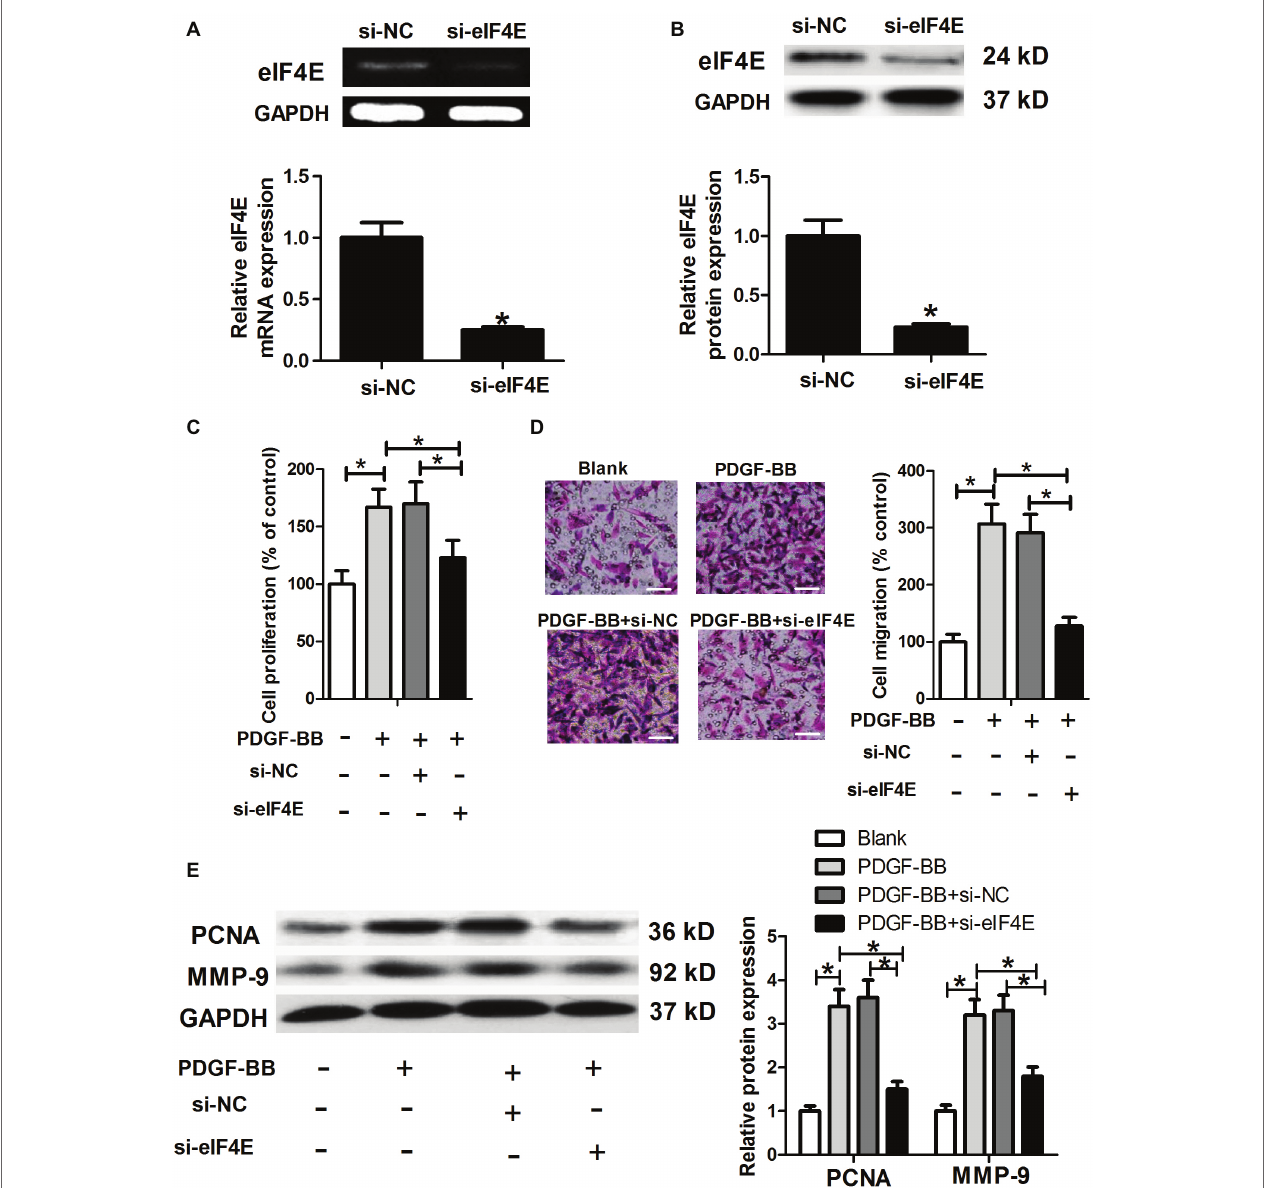
FIGURE 5 | eIF4E knockdown inhibits PDGF-BB-induced ASMC proliferation and migration. ASMCs are transfected with si-NC or si-eIF4E, and then are harvested for the following detections. (A,B) eIF4E mRNA and protein expression detected by RT-PCR and western blot, respectively. (C) Cell proliferation determined by MTT assay. (D) Cell migration detected by Transwell assay (scale bar: 100 μ m). (E) PCNA and MMP-9 expression determined by western blot assay. * p <